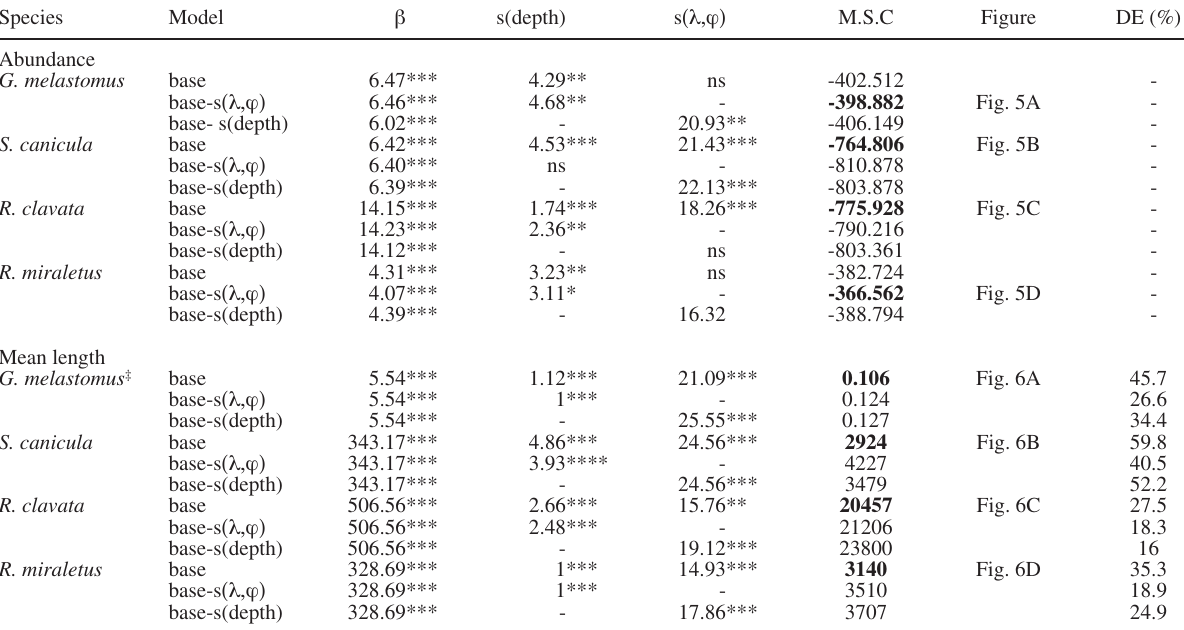
Table 4. – Model selection for the generalized additive model of abundance and mean length of the four species studied. Estimated intercepts ( b ) and estimated degrees of freedom for the two nonparametric terms are shown. The base model denotes the complete model including both bathymetric, s(depth), and geographic, s( l,j ), terms. Asterisks denote significance levels: ***: p<0.001;**: p<0.01; *: p<0.05 and ns: not significant or p ≥ 0.1. Note that the model selection criterion (M.S.C.) applied for the abundance models (COZIGAM) was the logarithmic marginal likelihood, while GCV (Generalized Cross Validation) was applied for regular GAMs. Figures showing the most parsimonious models are indicated. DE refers to the percentage of variance explained by regular GAMs (i.e. mean length); note that DE is not shown for abundance analyses due to the methodological constraints of COZIGAM (see Liu and Chan, 2010 for details). Note that the G. melastomus mean length intercept was considerably lower compared to the other mean length analyses due to the log-transformation prior to the analyses.